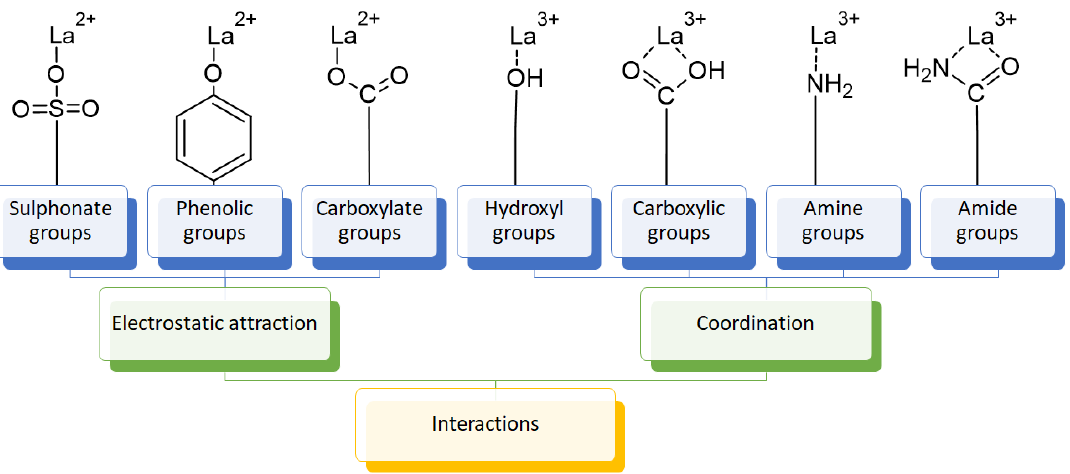
Figure 3. Interactions between REE cations and common functional groups included in polymeric materials for REE uptake.